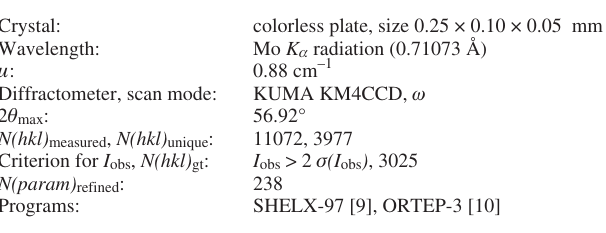
Table 1. Data collection and handling.